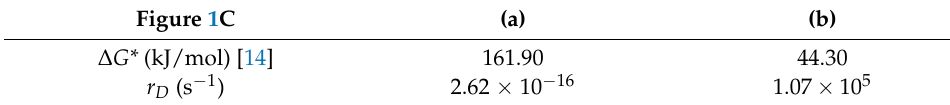
Table 4. Atomistic activation energy ( ∆ G *) [14] and the calculated atomistic forward reaction rates ( r D ) (Equation (1)) for the Ca-C3 dissolution on the (100) and (100) facets for 2 different event scenarios applied in case 4. Ca-C3 dissolution (Figure 1C): (a) in the presence of Si-C and (b) in the absence of Si-C.